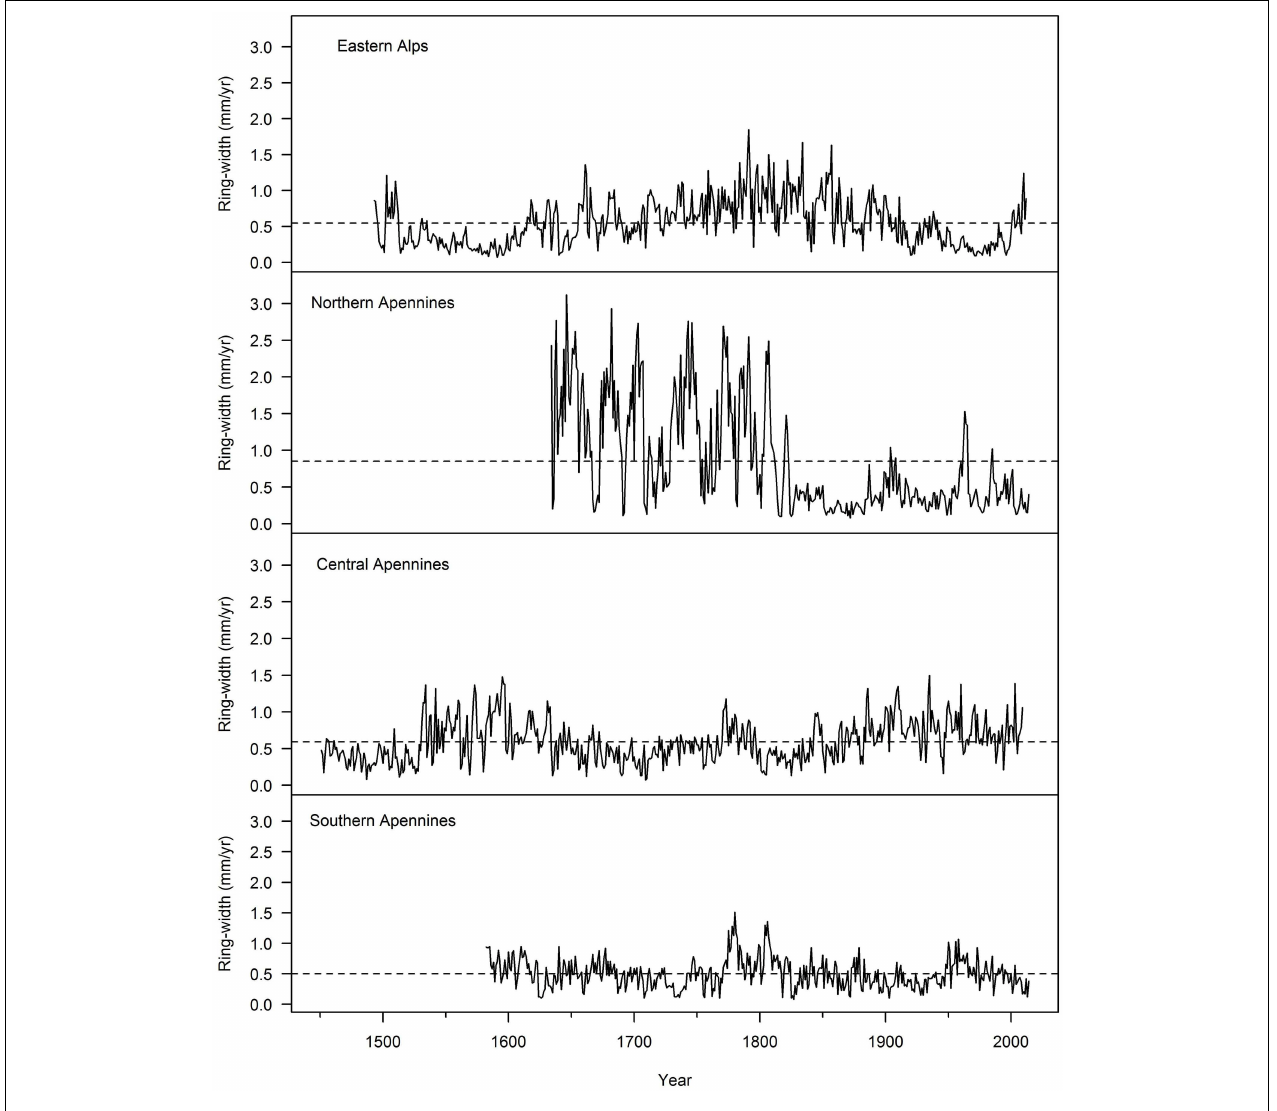
National Parks: Kalkalpen NP, Foreste Casentinesi NP, Abruzzi NP, and Pollino NP). The dotted line represents the average ring width of the